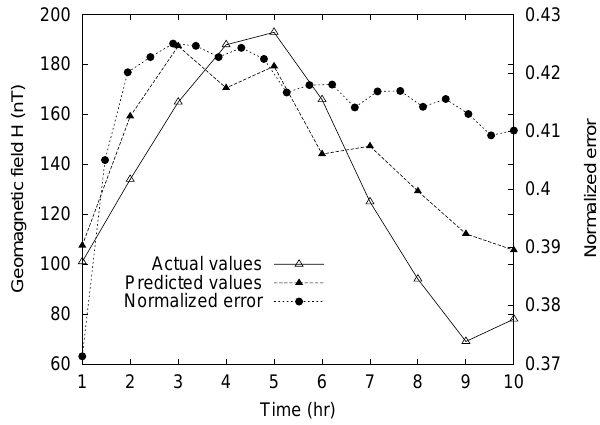
Fig. 12. The predicted (using the zero-order nonlinear prediction method) values of the times series of H is plotted along with the actual values and the normalized